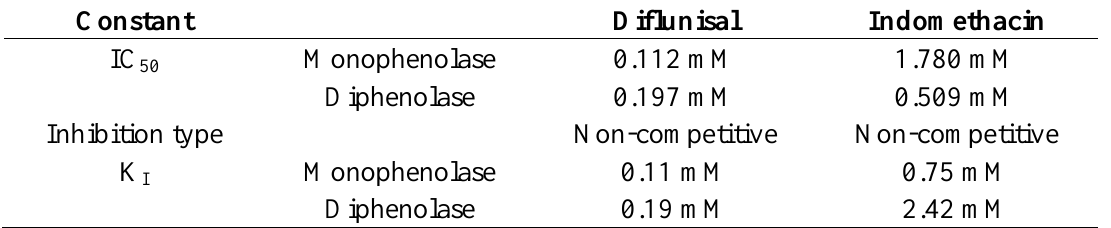
Table 2. Inhibition constants of diflunisal and indomethacin with mushroom